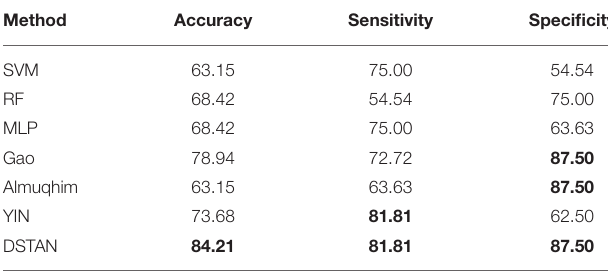
TABLE 2 | Performance of all methods on MCI